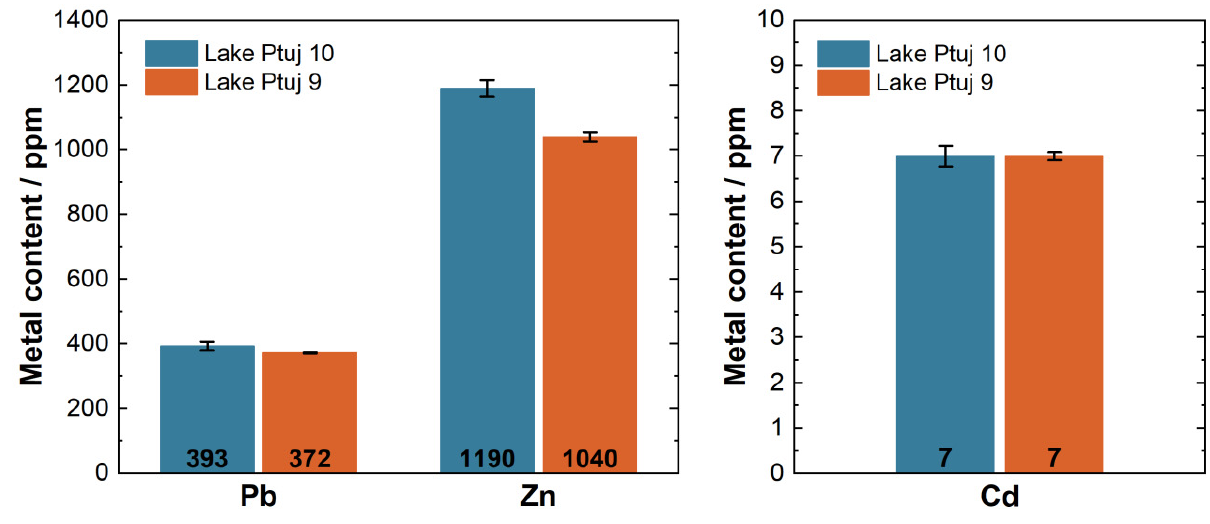
Figure 2. The average total metal contents in the Lake Ptuj 9 and Lake Ptuj 10 samples. According to the decree on the burdening of soil with waste spreading—the decree on soil pollution [33], the concentrations of Pb, Zn, and Cd also exceeded the limits for potential backfilling on agricultural land.